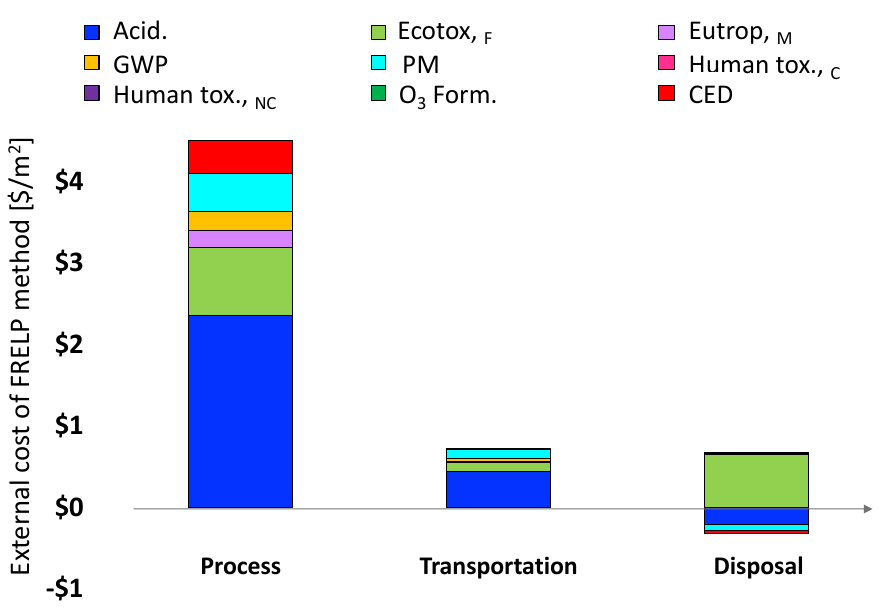
Figure 4. External costs of solar photovoltaic (PV) recycling.